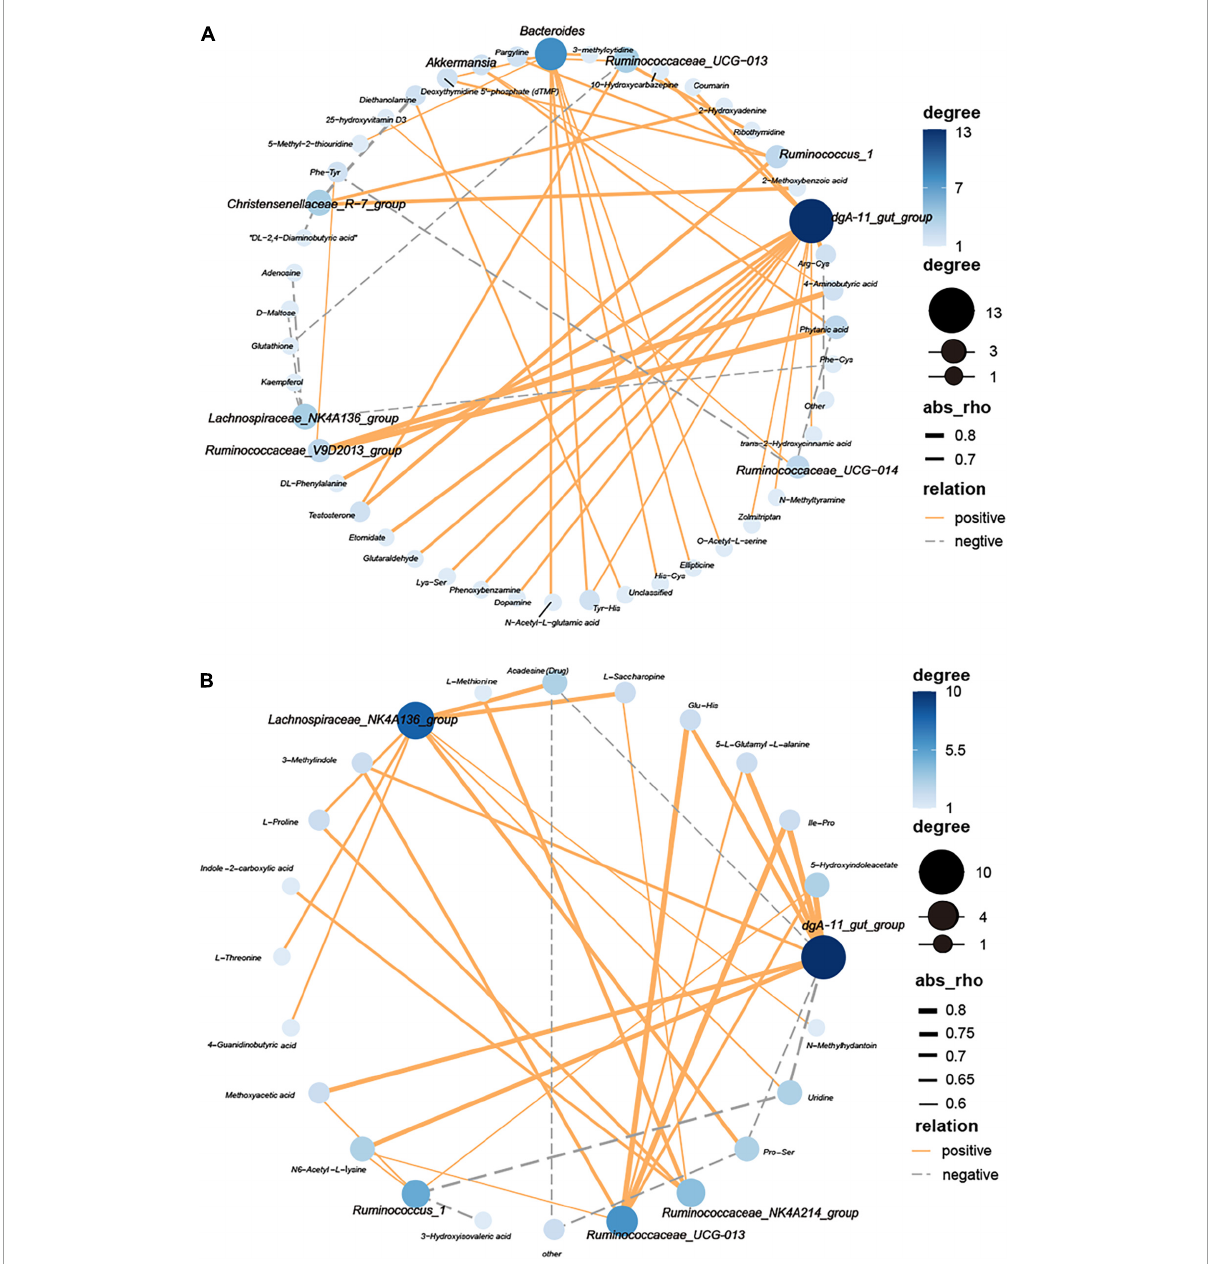
FIGURE8 Interaction network analysis between cecal bacteria (bold font) and plasma metabolites of Ira rabbits. (A) 53 days of age. (B) 67 days of age. Blue nodes represent the center degree of genera and metabolites. The node size indicates the level of center degree. Lines linked to nodes indicate significant correlations among the species (FDR adjusted P < 0.05, | r| > 0.5), with orange and gray colors showing positive and negative correlations,